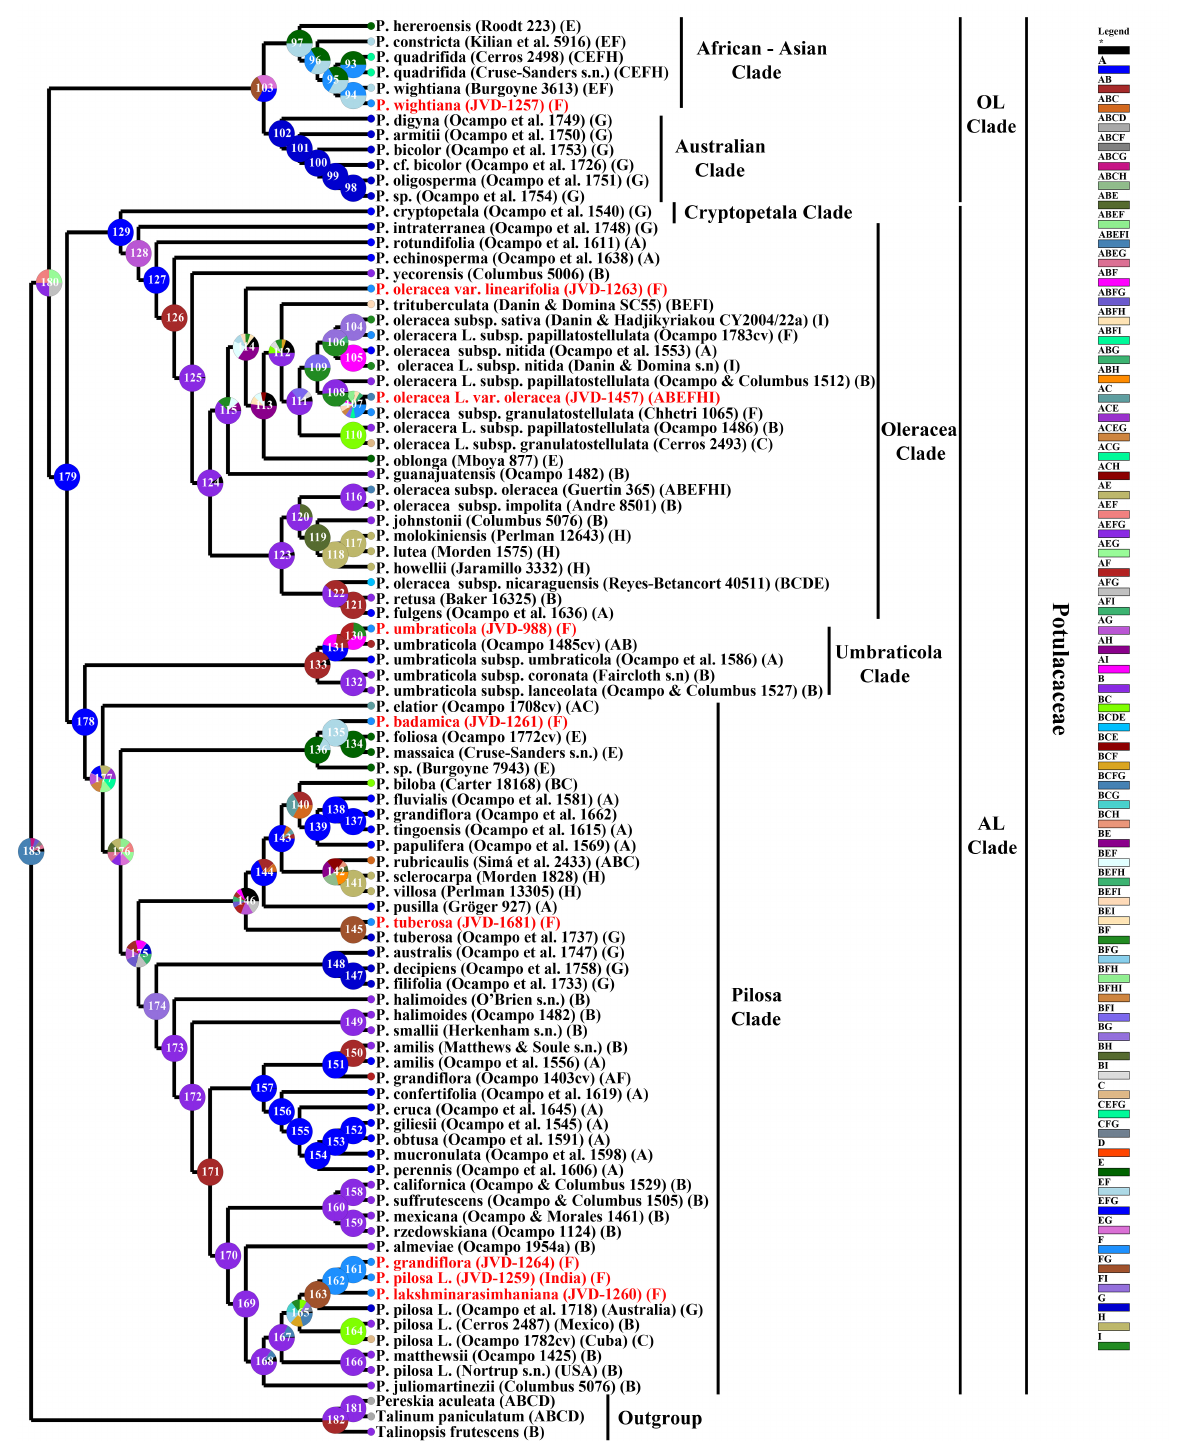
Figure 2. Graphical output from S-DIVA analysis (exported from RASP). The reconstruction is shown in a maximal S-DIVA value of 5058.717 based on the Bayesian tree with all compatible groups. After the tip of the tree, the taxa name with its voucher number is provided, and the distribution codes of the taxa are mentioned in brackets. Biogeographical regions: A: South America; B: North America; C: Caribbean; D: Central America; E: Africa; F: Asia; G: Australia; H: Islands of Pacific Ocean; I: Europe. The species sampled in this study are in red